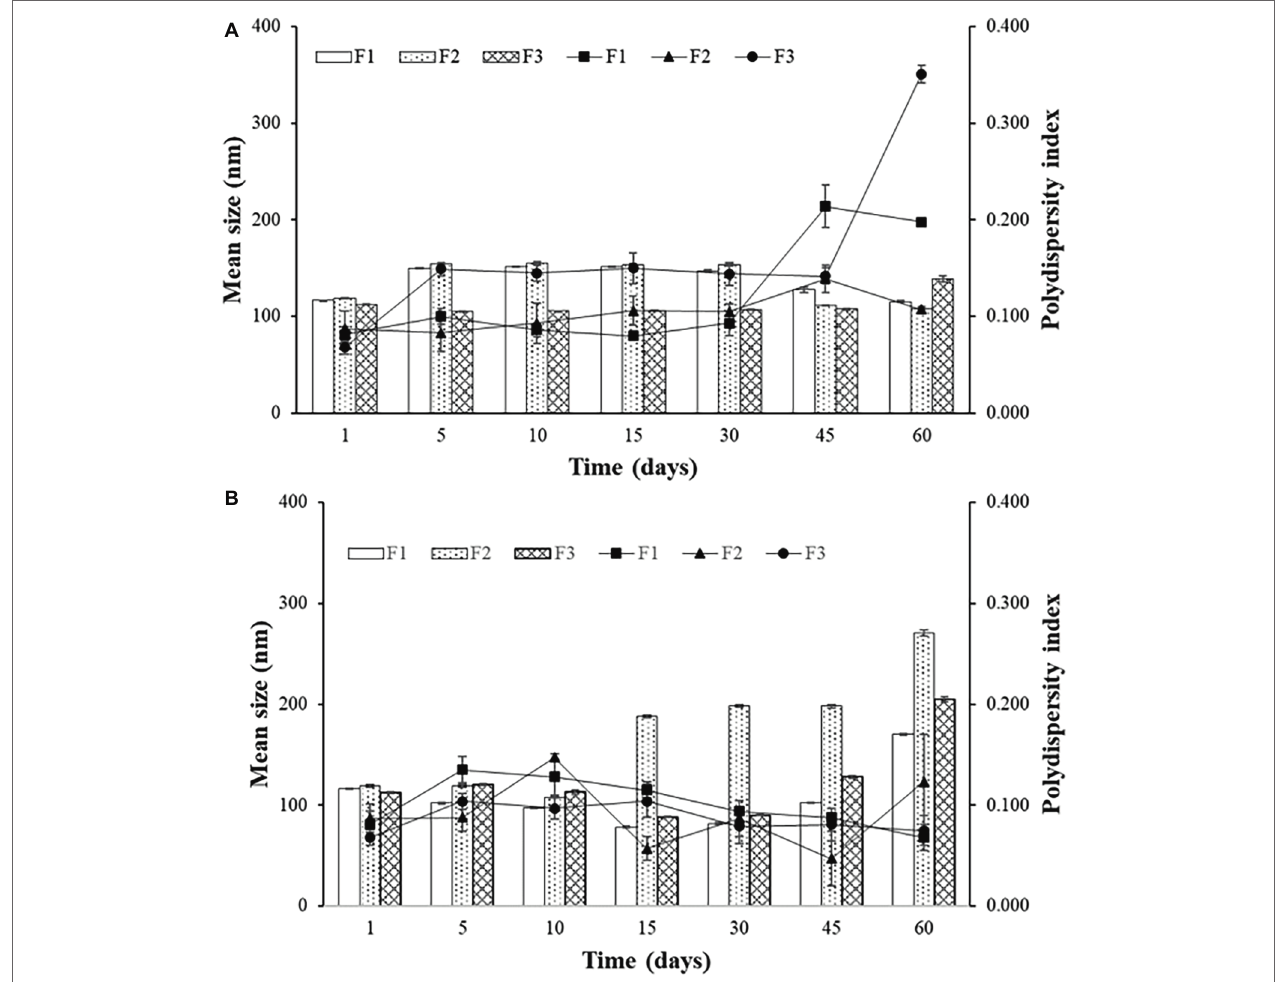
FIGURE 3 | Mean size and polydispersity index (PDI) for F1, F2, and F3 obtained by extrusion stored at 4 ° C (A) and at 37 ° C (B)